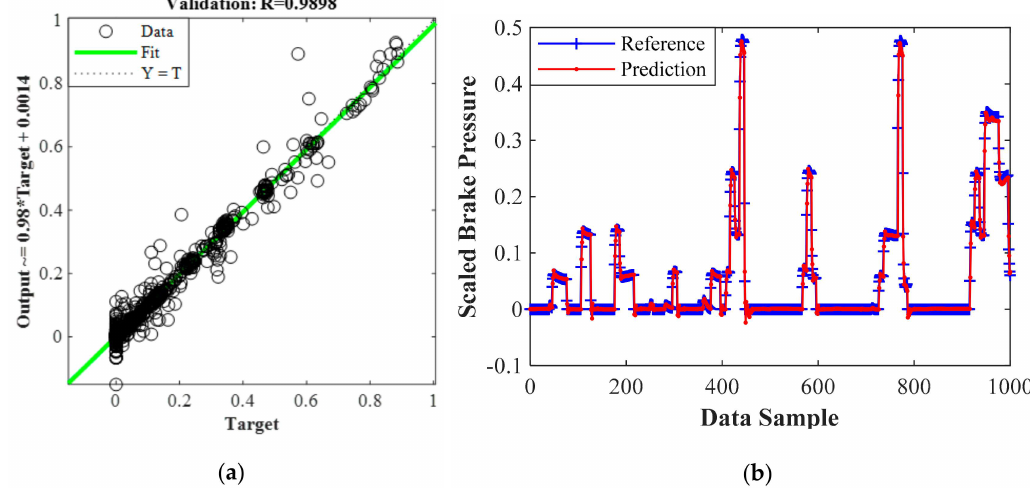
Figure 11. Brake intensity recognition results using the close-loop NARX network with 5 memory orders and 20 neurons. ( a ) Linear regression fit; ( b ) brake inensity recognition results.